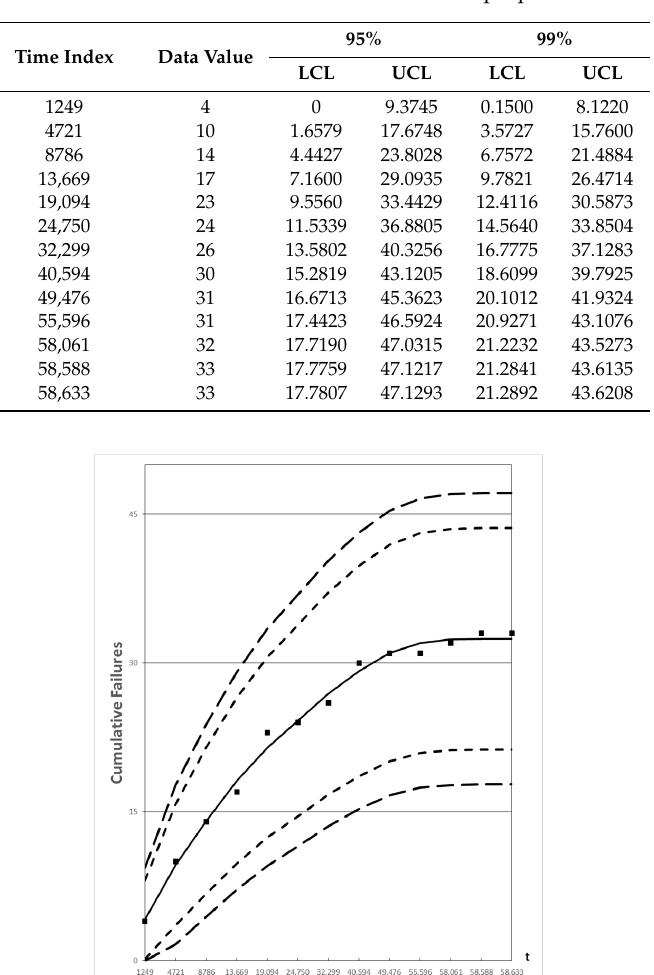
Figure 7. The 3D plot for dataset #2 ( a ) MSE value, model number, NCD value; ( b ) R 2 value model number, NCD value. Table 9. Results of the 95% and 99% confidence intervals for the proposed model for dataset #2.